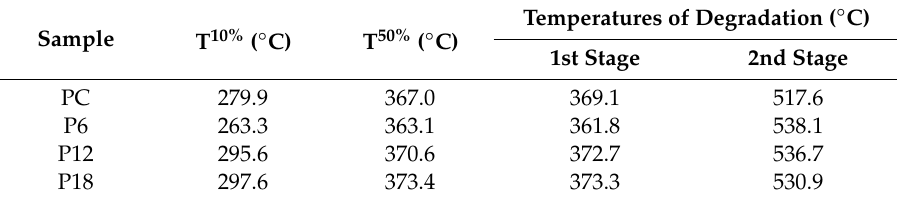
Table 5. Parameters determined from the thermogravimetric analysis.